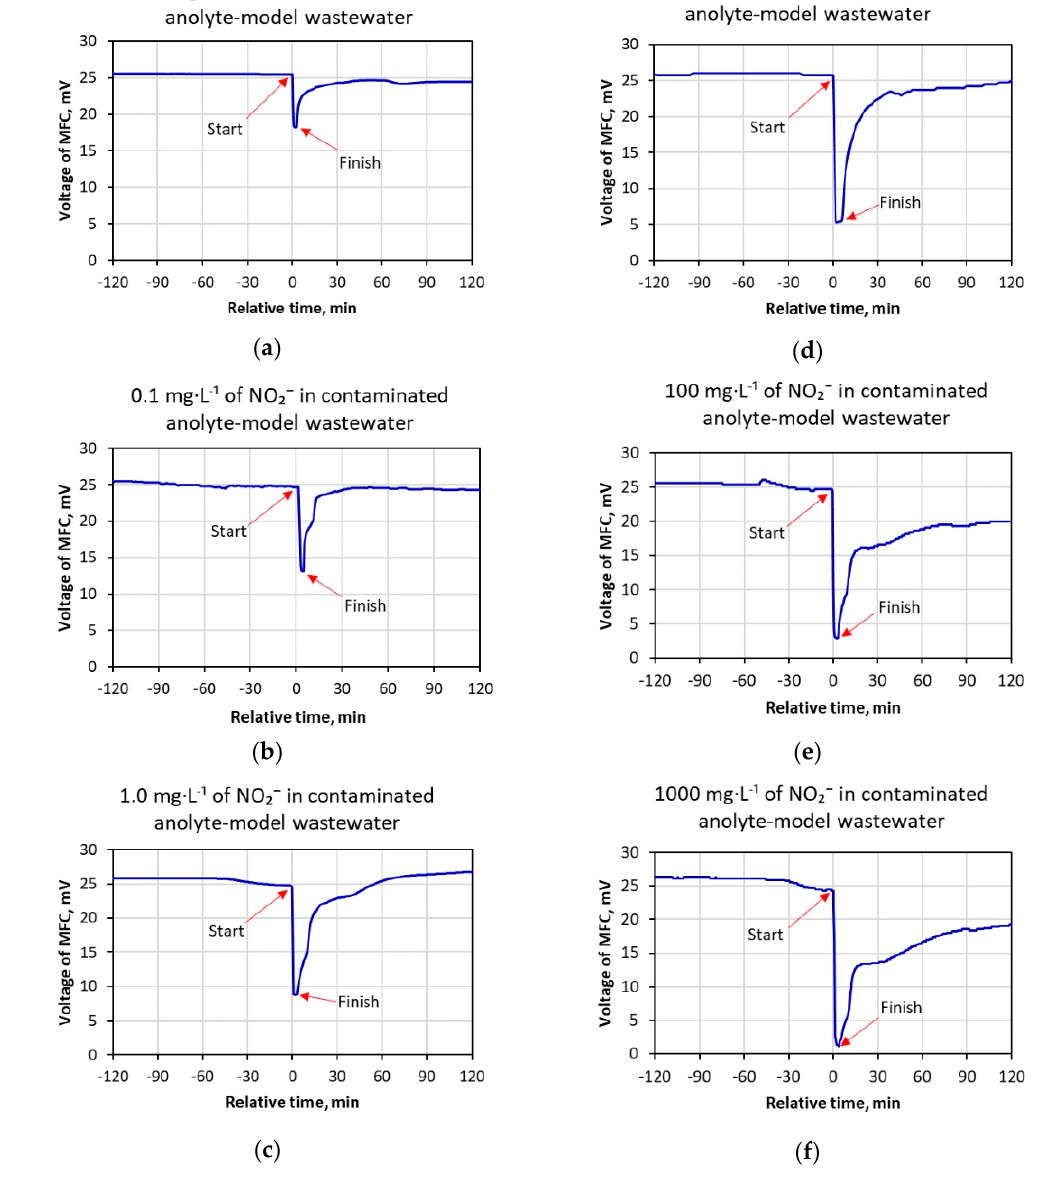
Figure 5. Variation of microbial fuel cell (MFC) voltage over relative time, when MFC was fed with nitrite-free anolyte-model wastewater (parts of the curves before Start point and after Finish point) and contaminated anolyte-model wastewater of different (( a ) 0.01 mg · L − 1 ; ( b ) 0.1 mg · L − 1 ; ( c ) 1.0 mg · L − 1 ; ( d ) 10 mg · L − 1 ; ( e ) 100 mg · L − 1 ; ( f ) 1000 mg · L − 1 ) nitrite ion concentration (part of the curves between Start and Finish points). “Zero” time moment indicates the start of the supply of the nitrite ion-contaminated anolyte into